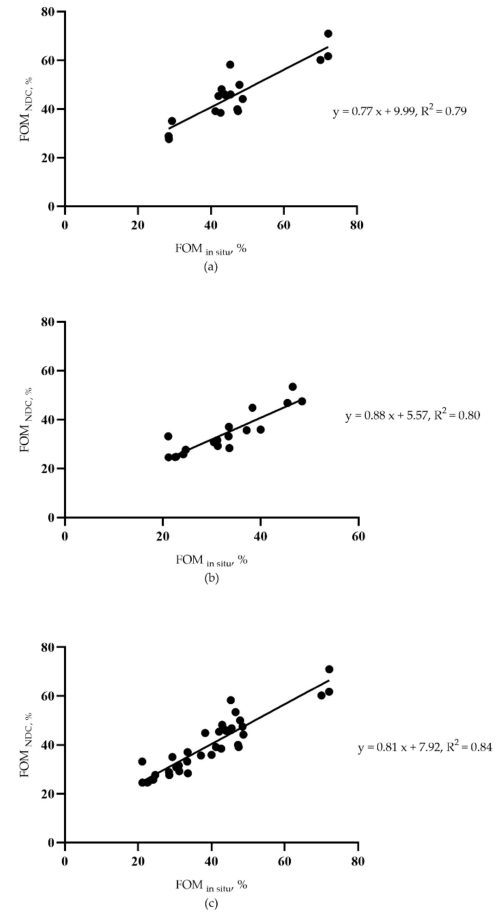
Figure 2. Linear equations of fermentable organic matter between determined by the in vitro neutral detergent–cellulase plus amylase method (x) and the in situ nylon bag technique (y) among forages ( a ), crop residues ( b ) and roughages ( c ),